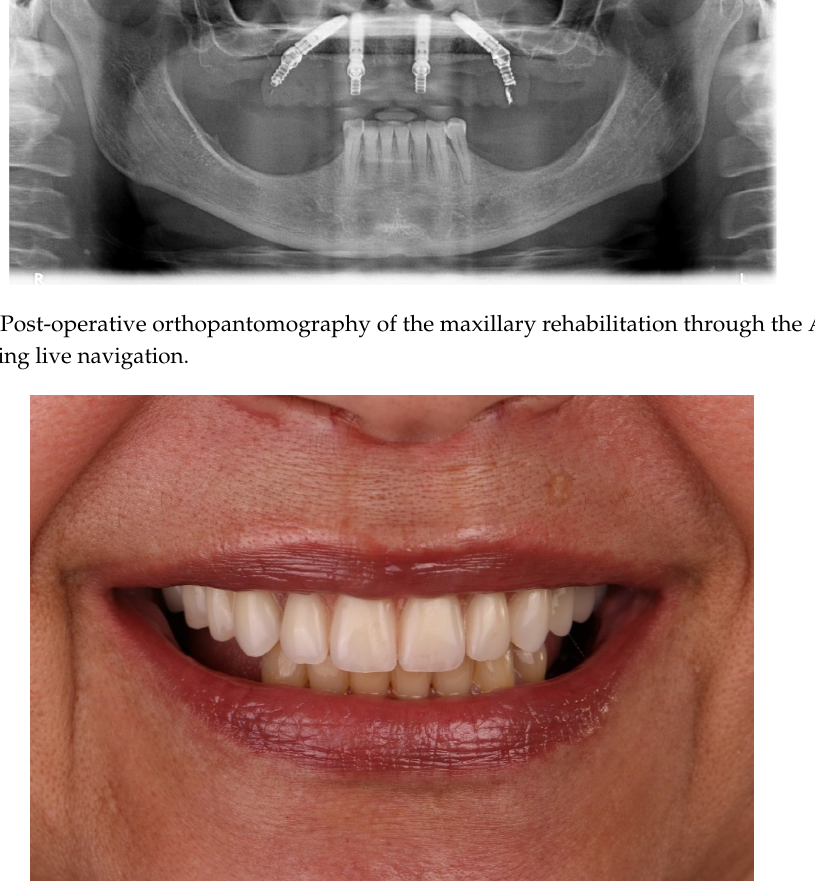
Figure 18. Patient smiling with the immediate full-arch implant-supported fixed prosthesis after 6 months of